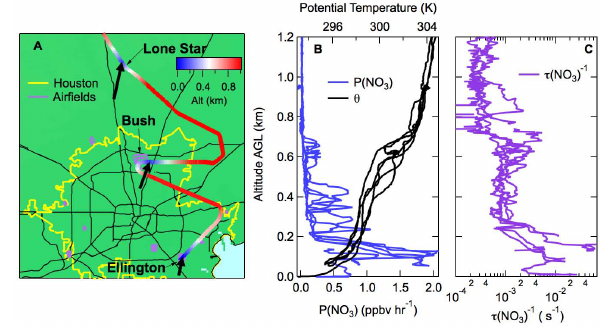
Fig. 10. Same as Fig. 2 except for the latter portion of the P-3 flight track on 11–12 October. Note that τ (NO 3 ) − 1 in (C) is on a loga- rithmic scale to show the contrast between its large increase in the lowest layer and its small values at high